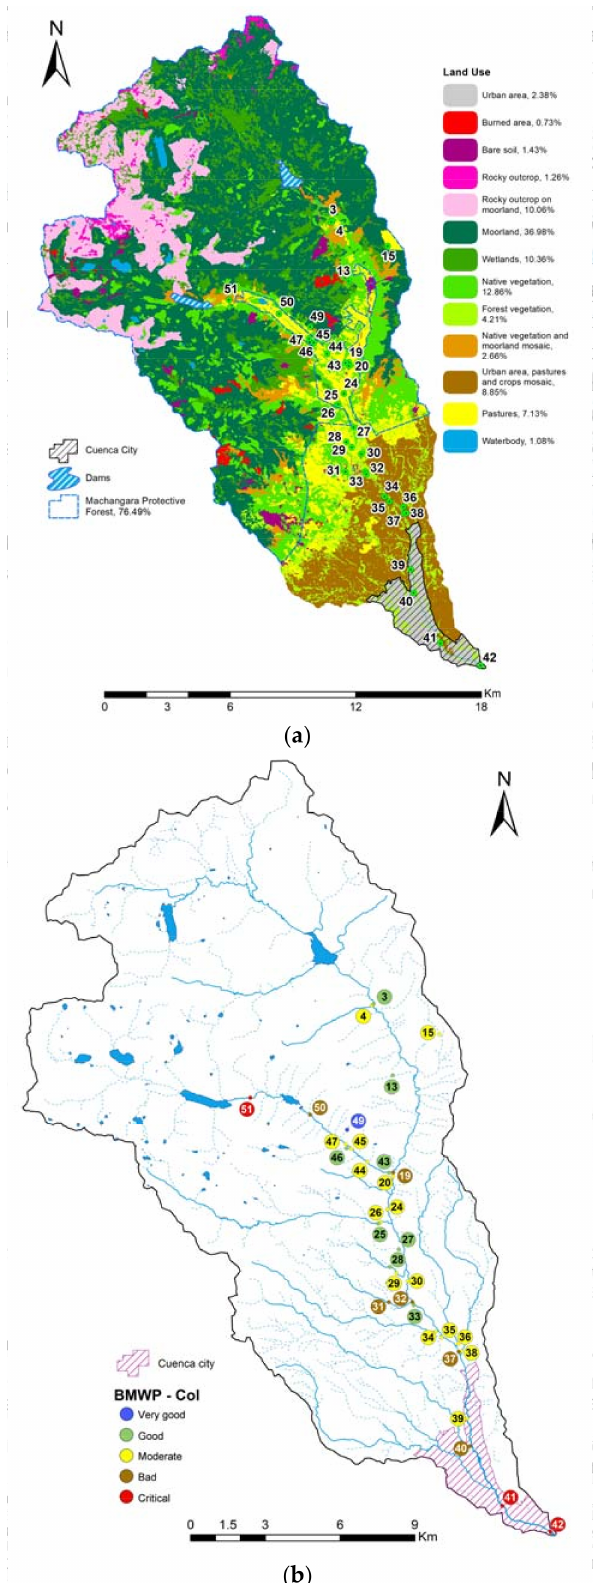
Figure 2. Sampled sites location with ( a ) land use; ( b ) Biological Monitoring Working Party score adapted to Colombia (BMWP-Col)